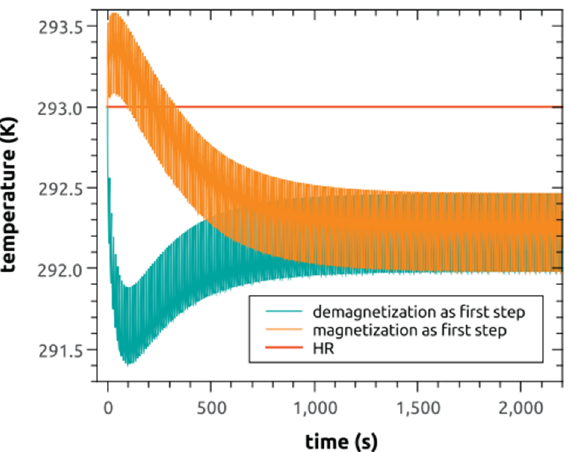
Figure 26. Temperature evolution in the middle of the cold tank versus the time for the best combinations of operating modes [111].